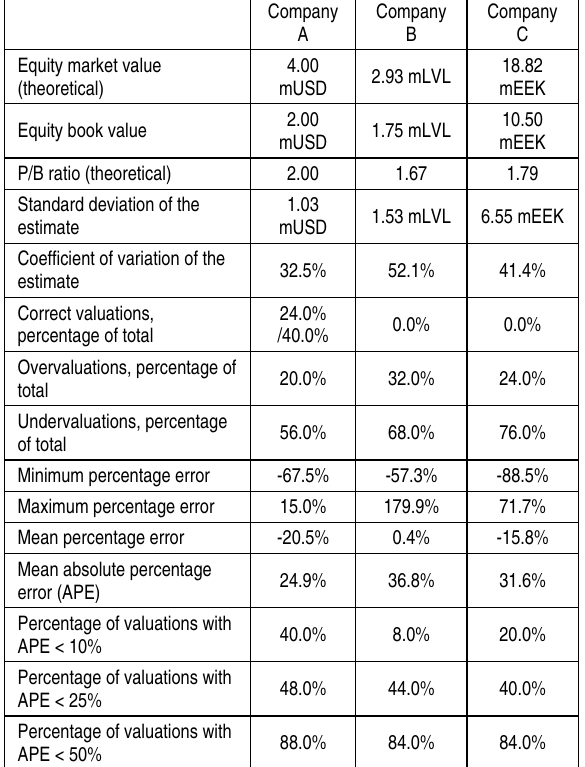
Fig. 1. Median, minimum and maximum estimated versus theoretical price-to-book ratios for three hypothetical companies Various appraisal error characteristics for these valuation cases are presented in the following Table 4. Table 4. Error characteristics for valuation cases of hypothetical